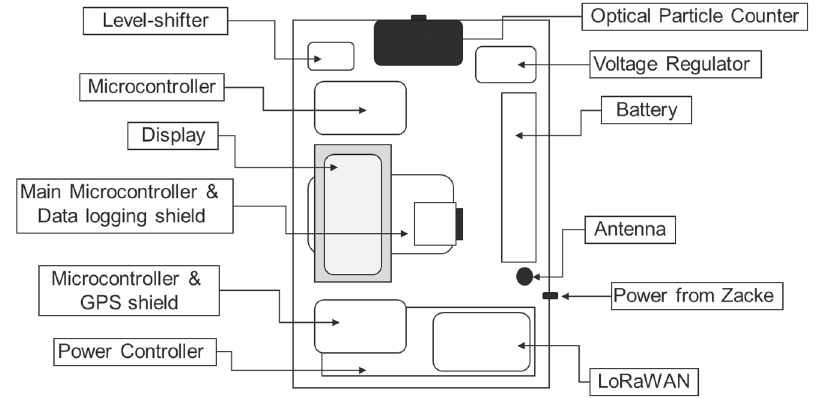
Figure 2. Layout of the sensor-monitoring box along with its components.